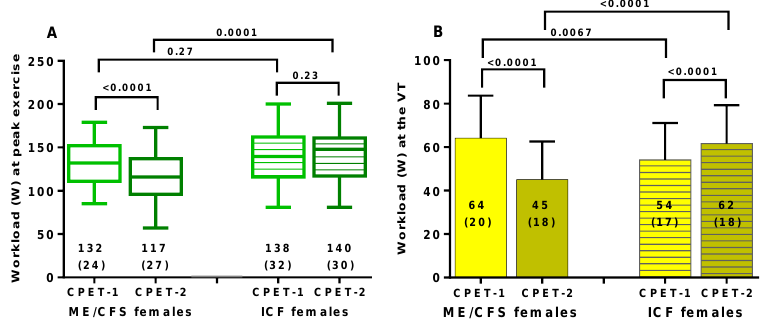
Figure 3. The workload at peak exercise for CPET-1 and CPET-2 (panel A ) and at the ventilatory threshold for CPET-1 and CPET-2 (panel B ). On the left side, the values of day 1 and day 2 are shown for female ME/CFS patients (clear boxes/columns); on the right side, the values of day 1 and day 2 are shown for female ICF patients (striped boxes/columns). Workload at peak exercise for CPET-1 and CPET-2 (panel A ) and at the ventilatory threshold for CPET-1 and CPET-2 (panel B ). Legend Figure 3: CPET: cardiopulmonary exercise test; ME/CFS: myalgic encephalomyelitis/chronic fatigue syndrome; ICF: idiopathic chronic fatigue; VT: ventilatory threshold.